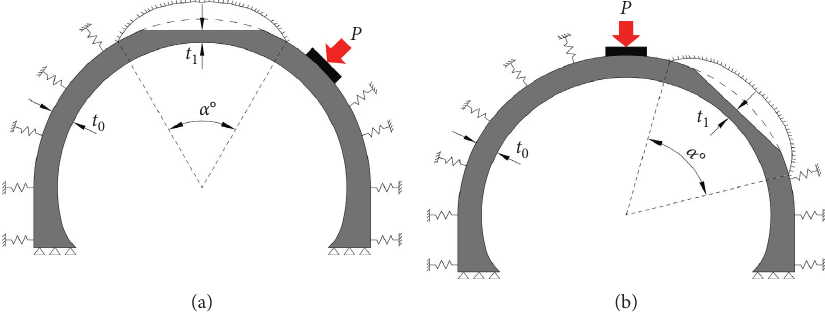
Figure 4: Model test case settings: (a) voids and thinning in the lining crown and (b) in the lining spandrel.